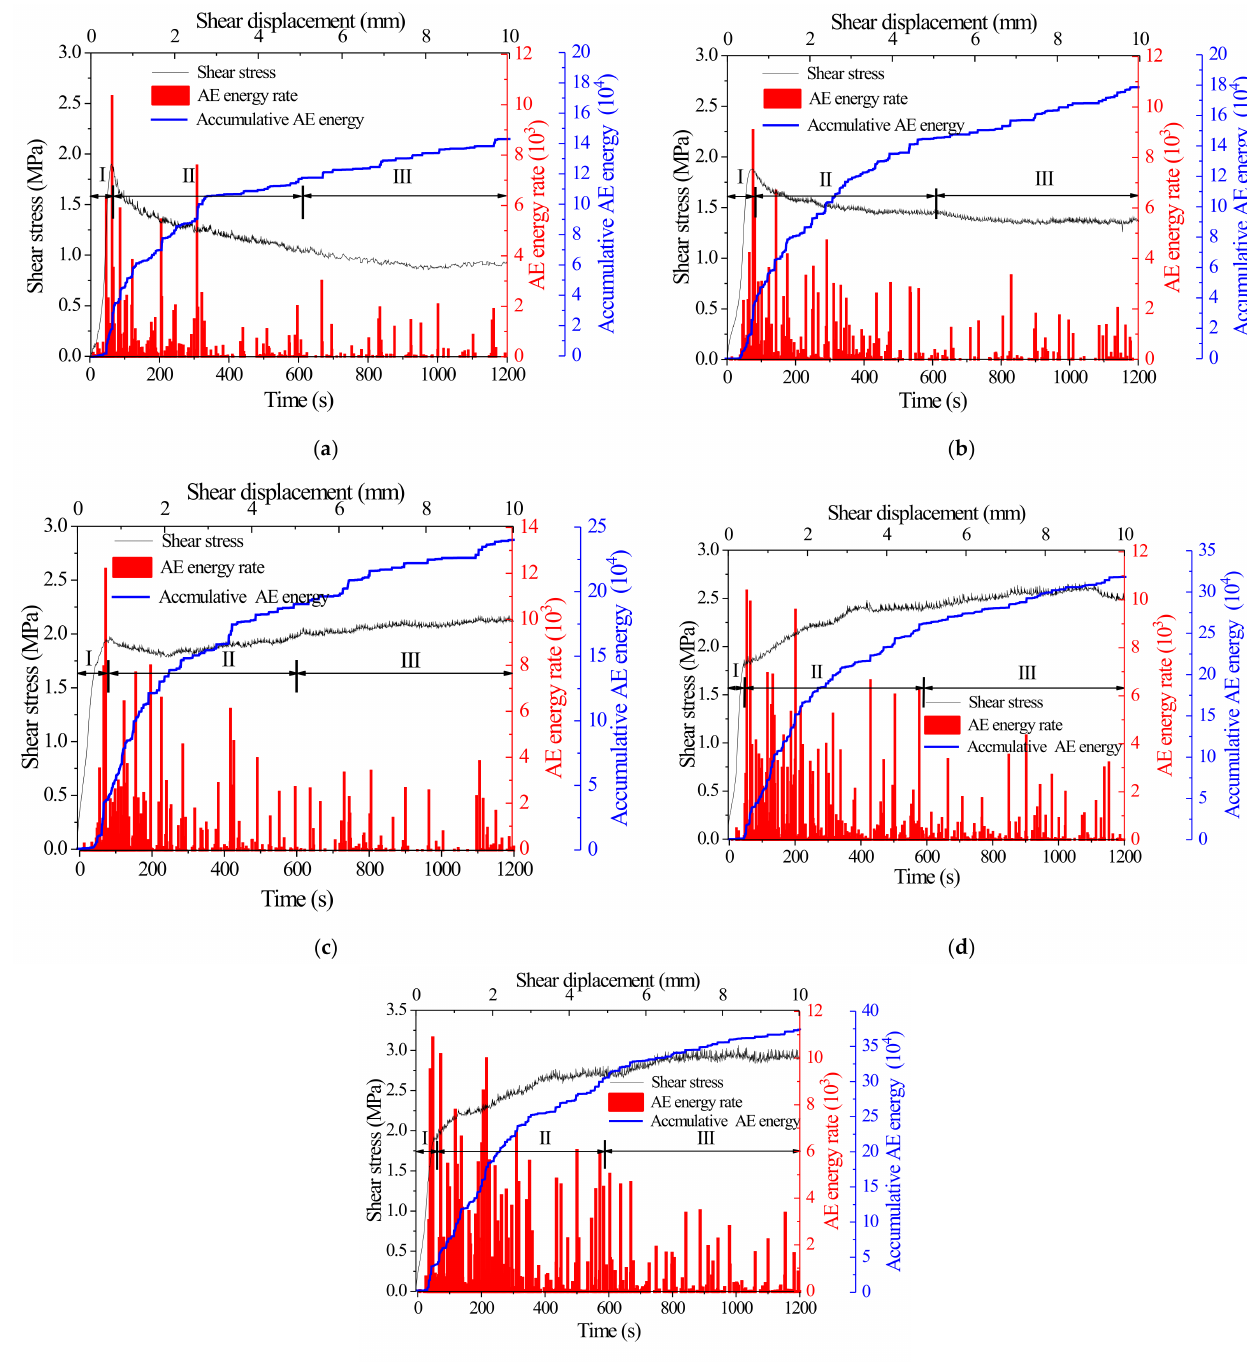
Figure 13. Difference of AE energy rate and amassed AE energy of joints under diverse normal stiff- ness status. ( a ) For k n = 0; ( b ) For k n = 1 MPa/mm; ( c ) For k n = 3 MPa/mm; ( d ) For k n = 5 MPa/mm; ( e ) For k n = 7